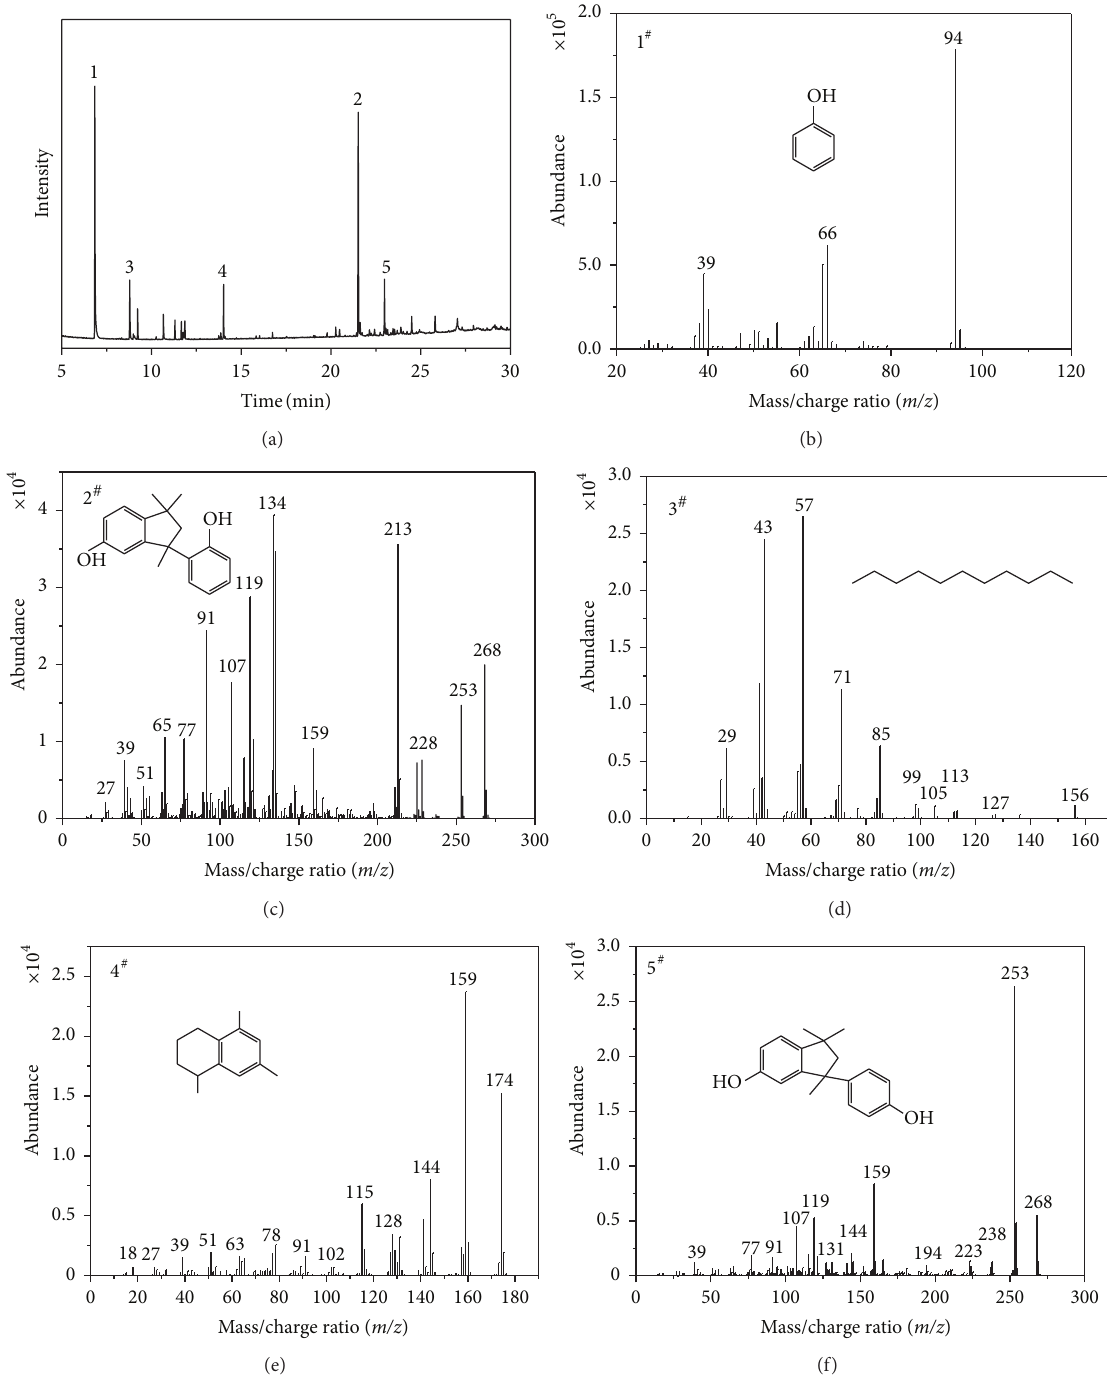
Figure 5: Chromatogram of the residues (a) and mass spectra of the five components from the residues (peaks 1–5 in the chromatogram) at different retention times of (b) 6.8min, (c) 21.5min, (d) 8.8 min, (e) 14.0min, and (f) 22.9